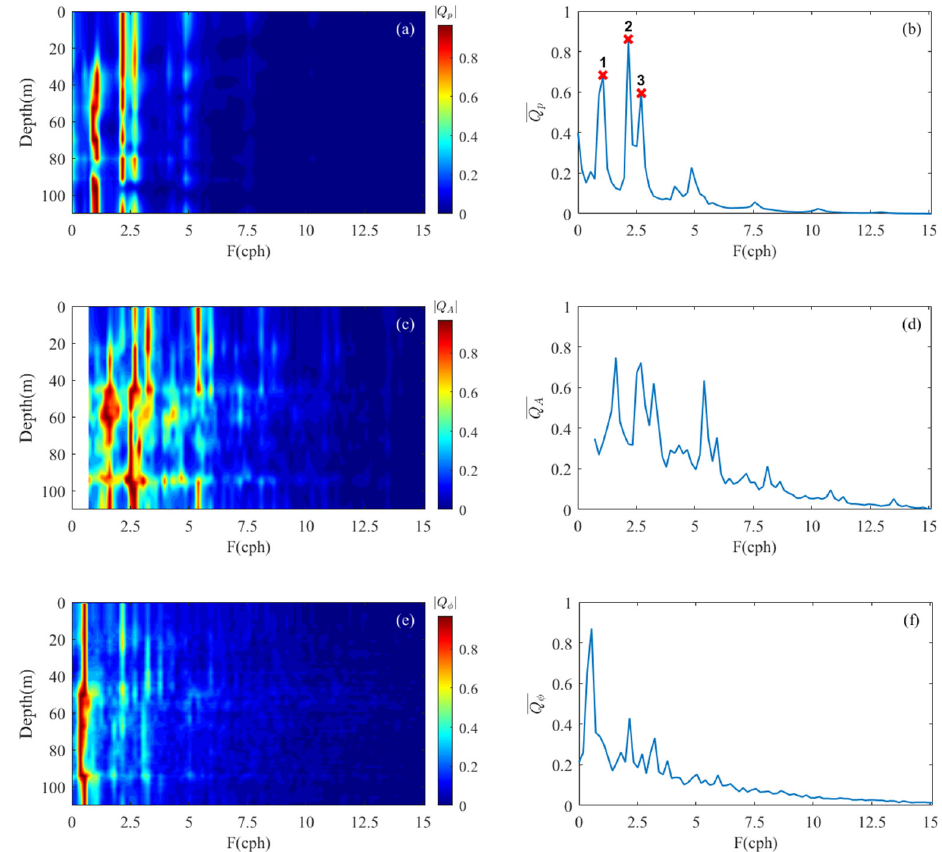
Figure 14. Spectra of the ( a , b ) complex sound pressure, ( c , d ) amplitude, and ( e , f ) phase. The left panels show contour plots of the normalized frequency-averaged spectra versus depth and fluctuation frequency F . The right panels show curves of depth-averaged spectra versus F . The three peaks of depth ‐ averaged curves 𝑄 (cid:3043) is marked with red cross.